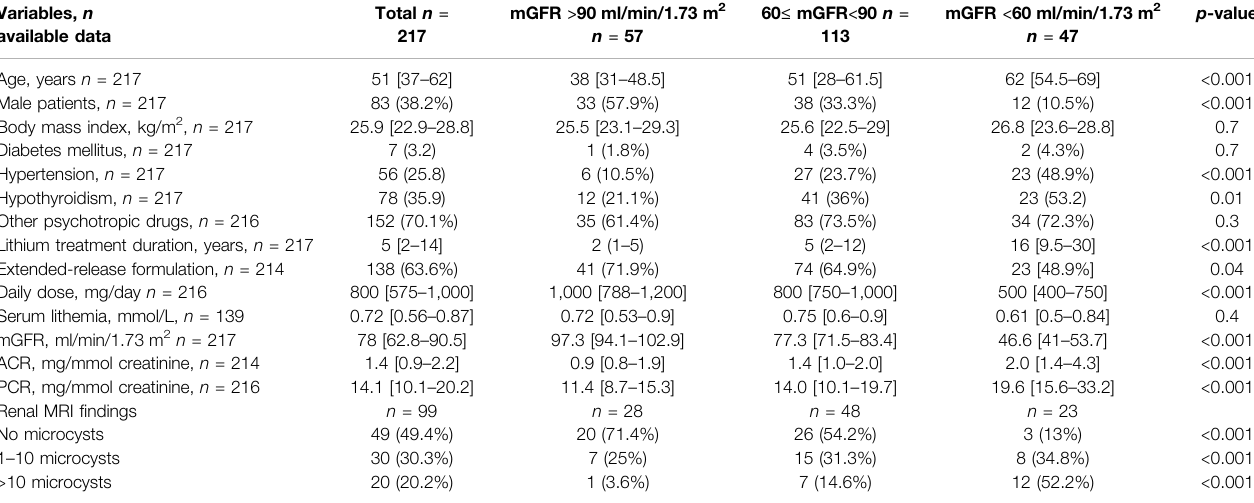
TABLE 1 | Characteristics of the patients in the whole cohort and according to measured GFR.